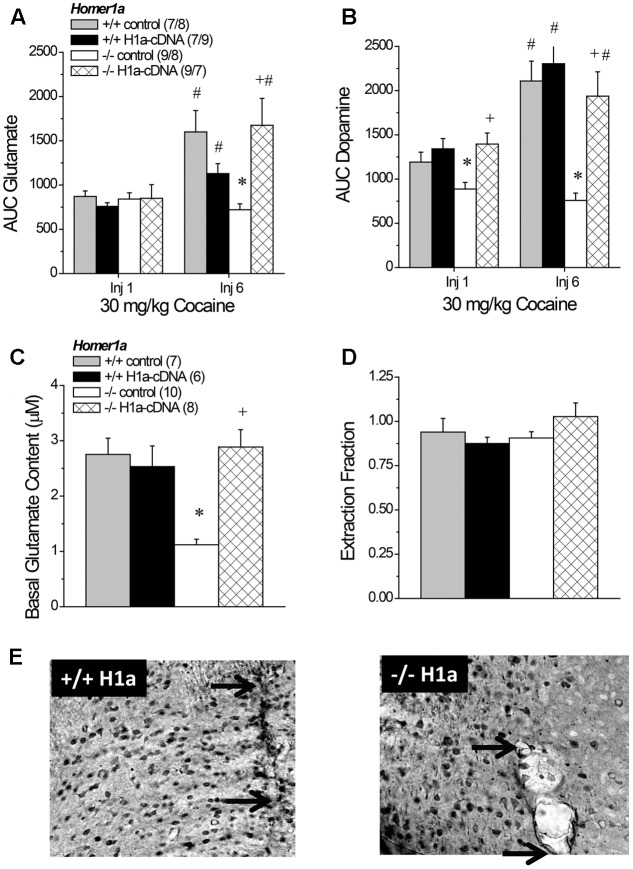
The effects of AAV-mediated restoration of Homer1a expression in Homer1a-/- mice upon basal and cocaine-stimulated neurotransmission. (A) Under conventional in vivo microdialysis procedures, repeated treatment with 30 mg/kg cocaine sensitized cocaine-induced glutamate release in both Homer1a+/+ infused intra-NAC with AAV, but only in Homer1a-/- mice infused with AAV-Homer1a (H1a). (B) Intra-NAC AAV-Homer1a infusion increased the magnitude of the cocaine-elicited rise in dopamine in Homer1a-/- mice and facilitated the expression of dopamine sensitization with repeated cocaine treatment. The sample sizes in (B) are presented in (A). When determined using glutamate no net-flux procedures, intra-NAC AAV-Homer1a reversed the low basal glutamate phenotype of Homer1a-/- mice (C), but did not alter the slope of linear regressions in either genotype (D). The samples sizes in (D) are presented in (C). The data in (A–D) represent the mean ± SEM of the number of mice indicated in parentheses. ∗p < 0.05 vs. respective +/+; +p < 0.05 vs. respective AAV control; #p < 0.05 vs. Injection 1 (sensitization). (E) Representative images of HA-staining within the NAC of Homer1a+/+ (left) and Homer1a-/- mice (right) infused with AAV-Homer1a (20X magnification), illustrating comparable neuronal transduction around the site of microinjection/microdialysis probe insertion. Arrows in (E) represent the extent of the microdialysis probe membranes.